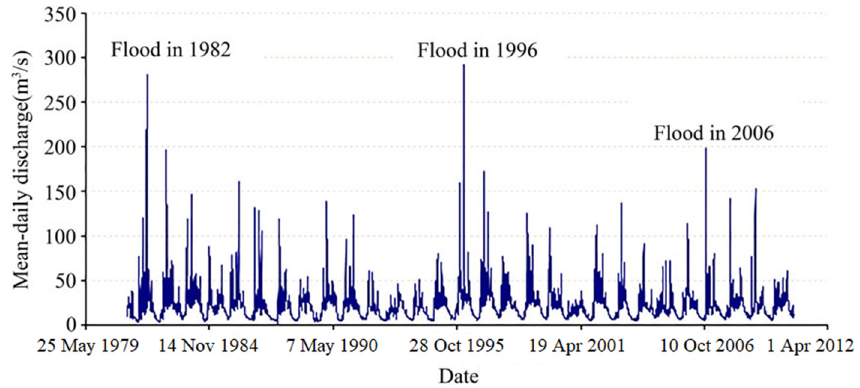
Figure 5. Flow series developed for upper NFTR at SRS [20].